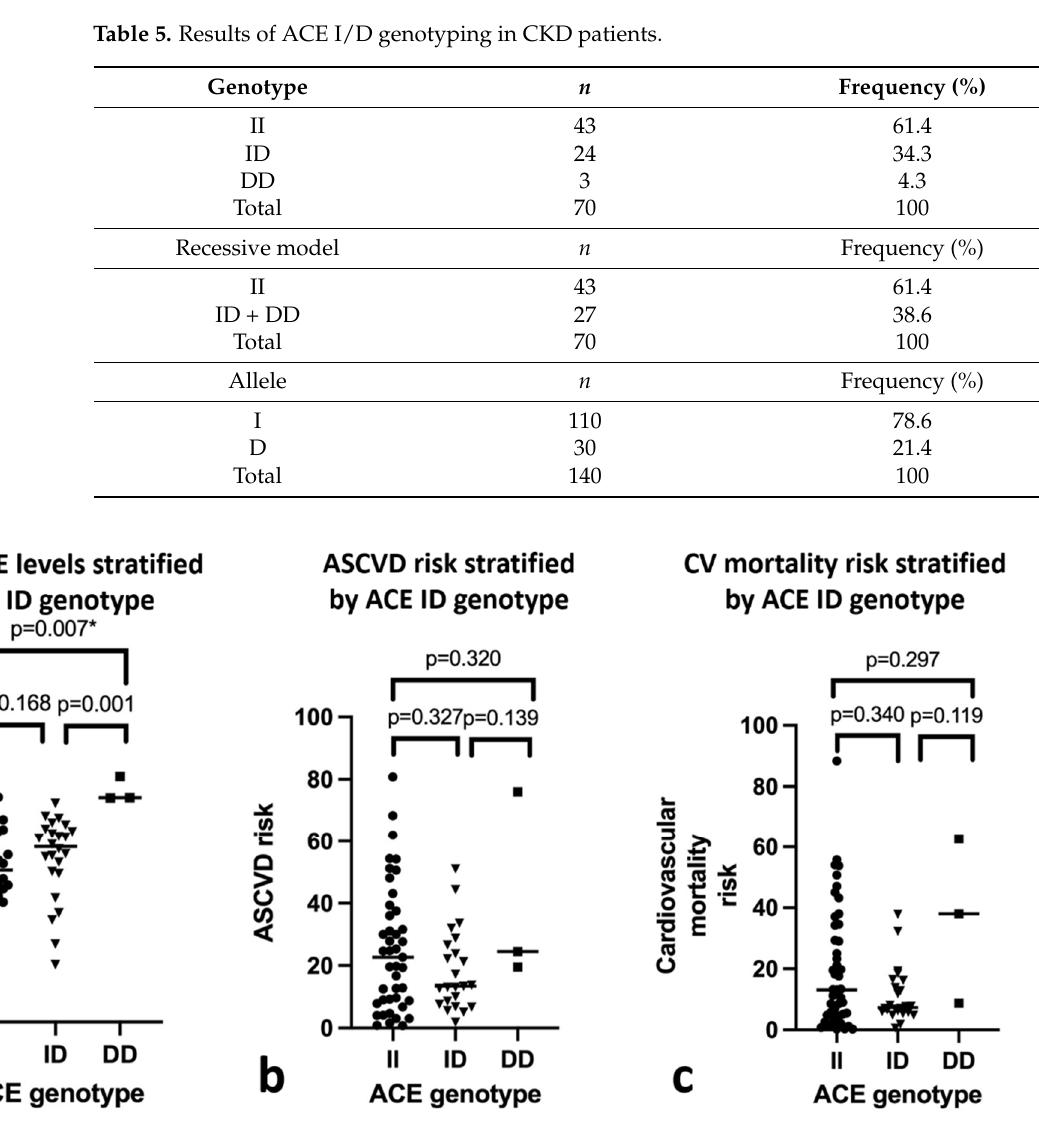
Figure 6. Relationship between ACE I/D polymorphism, plasma ACE level, atherosclerotic cardiovascular diseases risk, and cardiovascular mortality risk showed with path coefficient ( p - value) on each pathway. Table 6. Direct, indirect, and total effects of the path analysis. Outcome